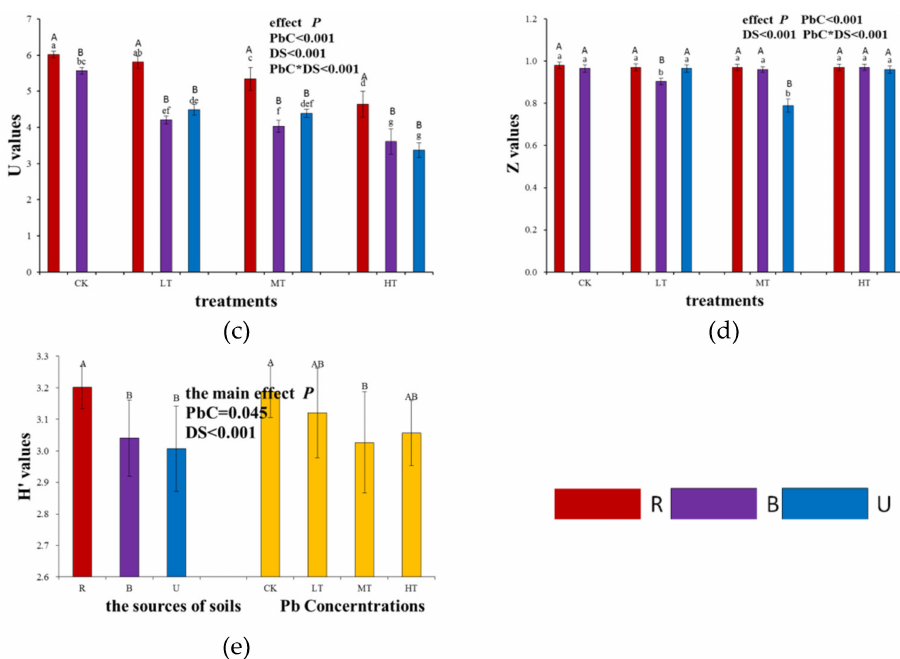
Figure 7. Microbial communities diversity indices of richness index (S, a ), Shannon’s evenness index (E, b ), McIntosh’s diversity index (U, c ), McIntosh’s evenness index (Z, d ) and Shannon’s diversity index (H (cid:48) , e ) based on 144h data from Biolog analysis under different treatments. CK, 0 mg/kg; LT, 500 mg/kg; MT, 1000 mg/kg; HT, 1500 mg/kg; R, rhizospheric soil; B, bulk soil; U, unplanted soil. PbC, Pb concentration effect; DS, different sources of soil; PbC × DS, the interactive effect of Pb concentration and different sources of soil. Different letters indicate that values differ significantly at p < 0.05. The lowercase letters represent the global comparison and uppercase letters represent the intra-soil type comparisons. Values represent mean ± SD ( n =